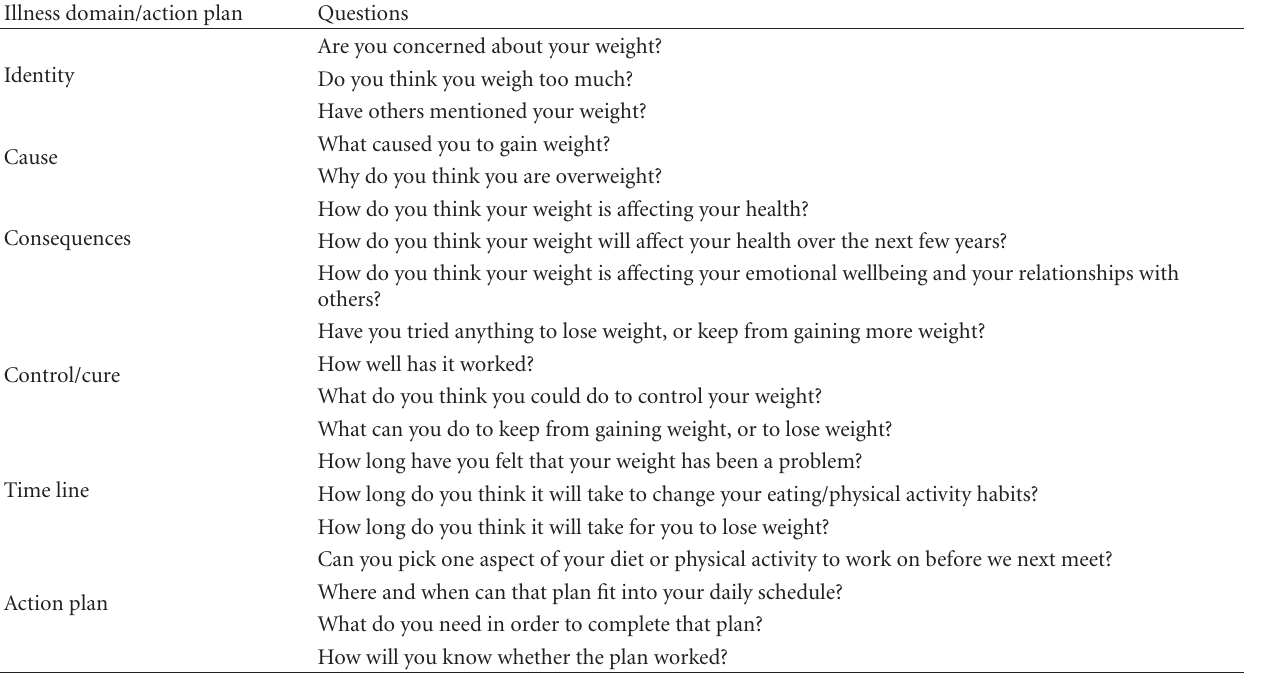
Table 1: Questions that can be used to assess patients’ illness representations and action